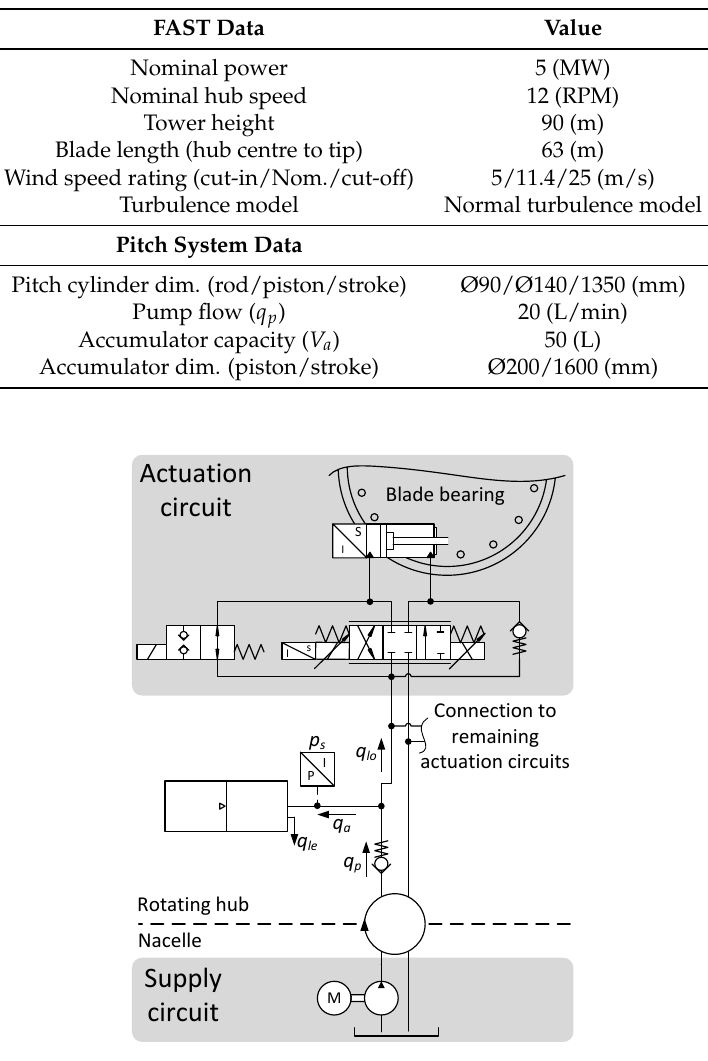
Table 1. Main data for the wind turbine and pitch system simulation model.